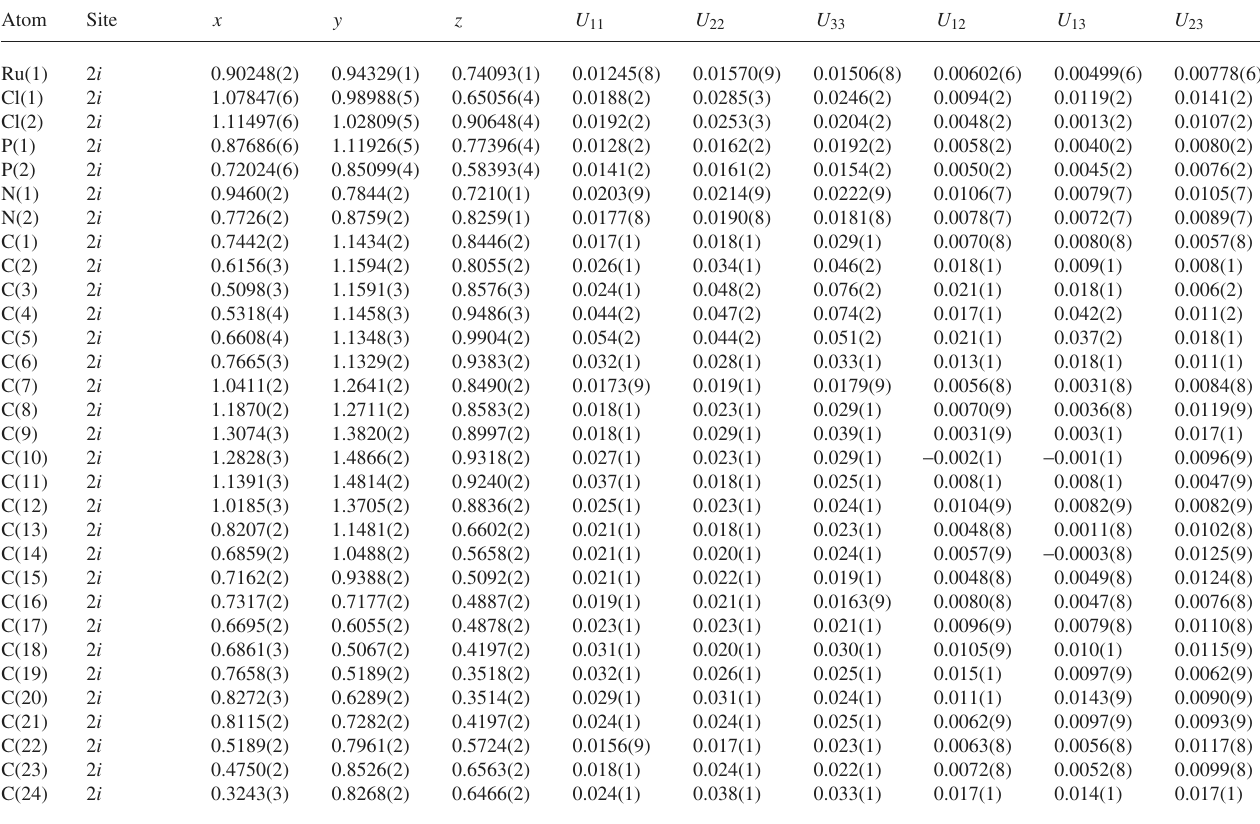
Table 3. Atomic coordinates and displacement parameters (in Å 2 ) .